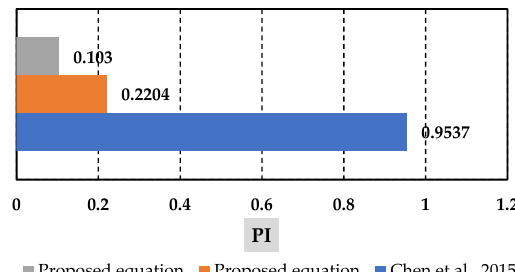
Figure 20. The change diagrams of each indicator for the ultimate strain model are presented by Chen and Andrawes [26] and also for the proposed models.